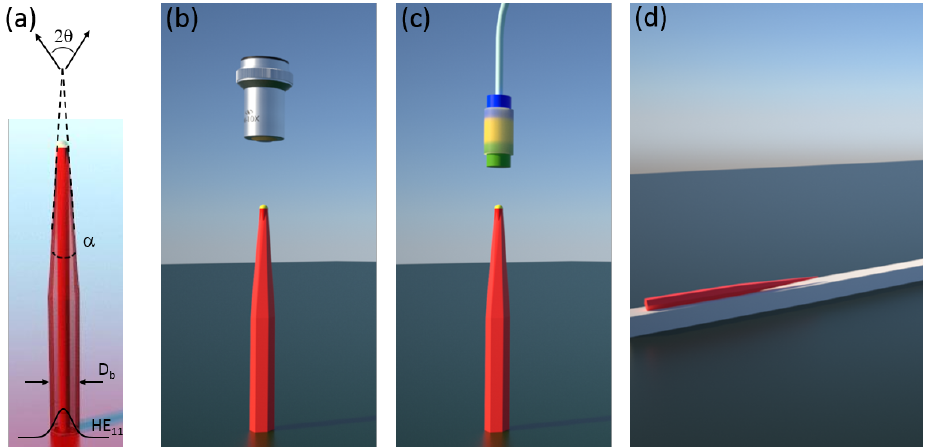
Figure 1. ( a ) Schematic of a nanowire-based quantum dot single photon source. Different implemen- tations of the source: ( b ) Free-space coupled. ( c ) Fibre-coupled using graded index lenses. ( d ) On-chip using evanescent coupling of the nanowire optical mode to an underlying ridge